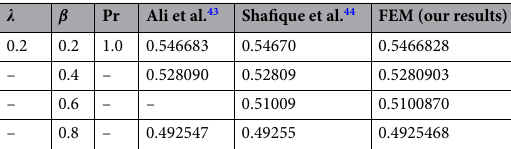
1 and different values of rotating parameters (cid:31) when θ ′ ( 0 ) for ζ = −